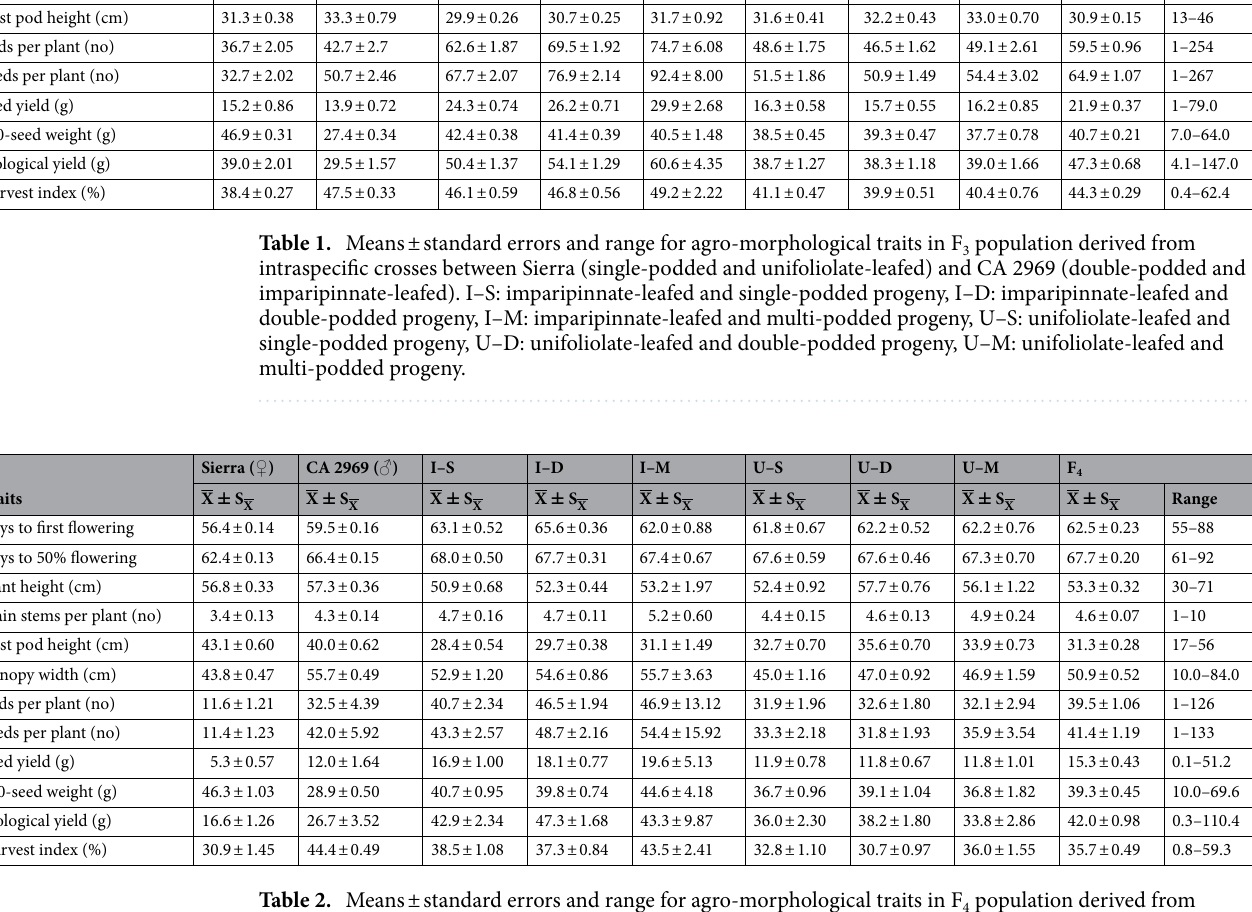
Superior lines for agro-morphological traits in the F